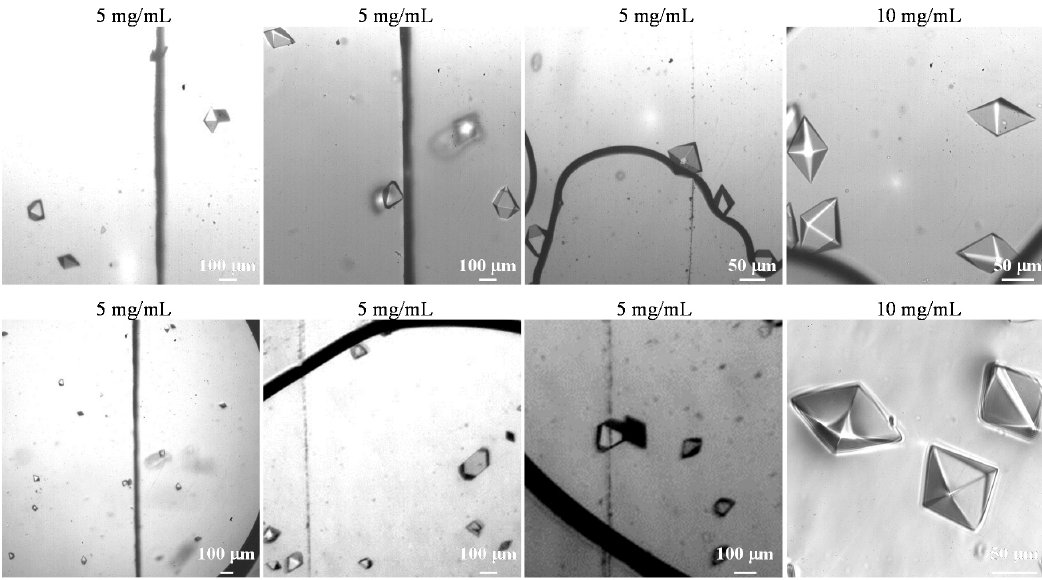
Figure 5. Optical micrographs of lysozyme and proteinase K from repeated experiments on different samples of the substrate S 40%|4 with incision.